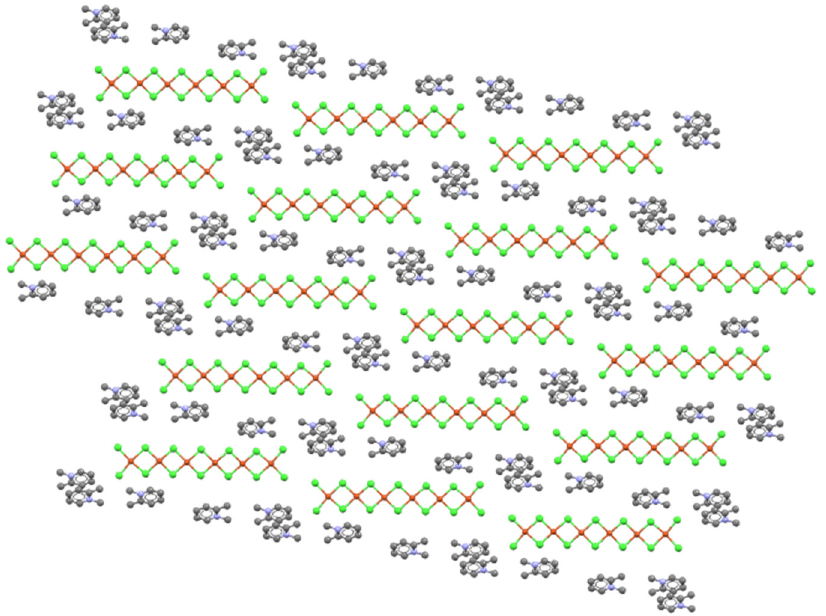
Figure 10. View of the mixed organic cation/oligomer sheet in (1,2-dimethylpyridinium) 2 Cu 6 Cl 14 (ZACSIF) viewed perpendicular to the (230) plane.